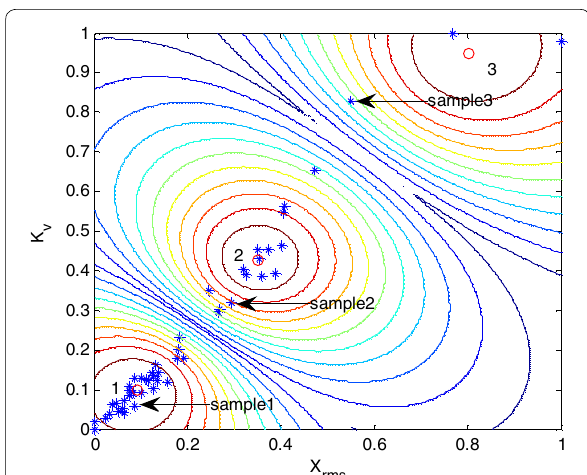
Figure 14 FCM cluster result of high speed bearing